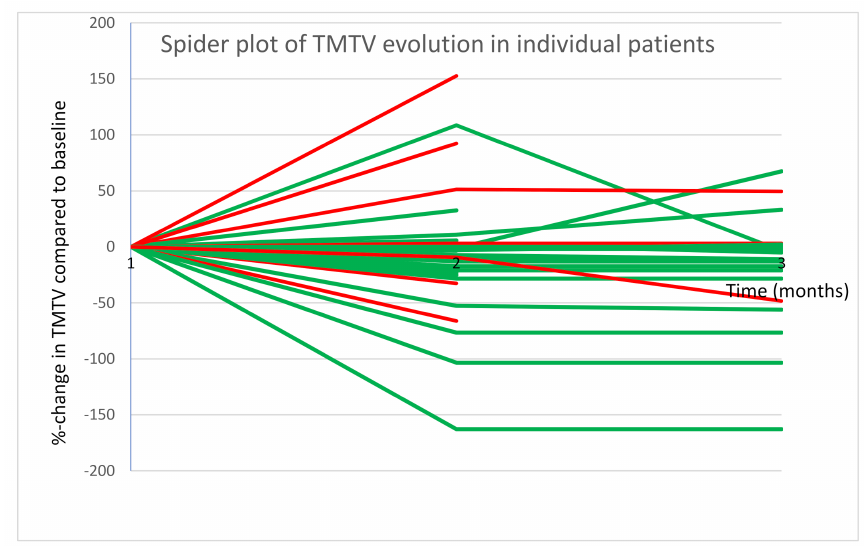
Figure 6. Spider plot demonstrating %-change in TMTV compared to baseline at 2–4 m and 5–6 m after onset of Pembrolizumab; Patients with PD within one year are shown in red and those without PD in